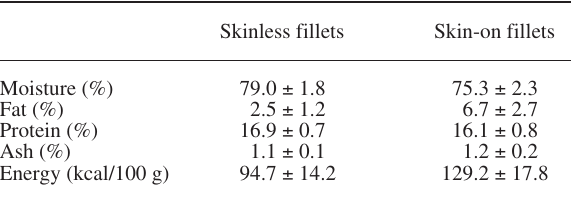
Table 1. – Proximate chemical composition (% wet weight; mean ± standard deviation) and energy values (kcal/100 g wet weight; mean ± standard deviation) of skin-on and skinless black scabbardfish